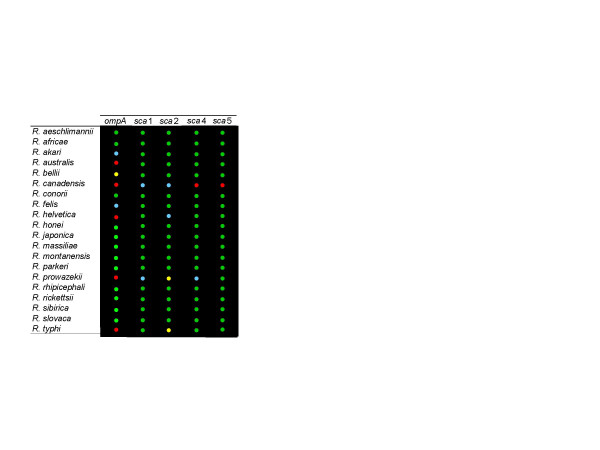
Current knowledge on the distribution of the ompA, sca1, sca2, sca4, and sca5 genes among the 20 validated Rickettsia species. Green dots indicate complete genes, whereas blue dots indicate split genes, yellow dots indicate gene fragments, and red dots indicate absent genes.